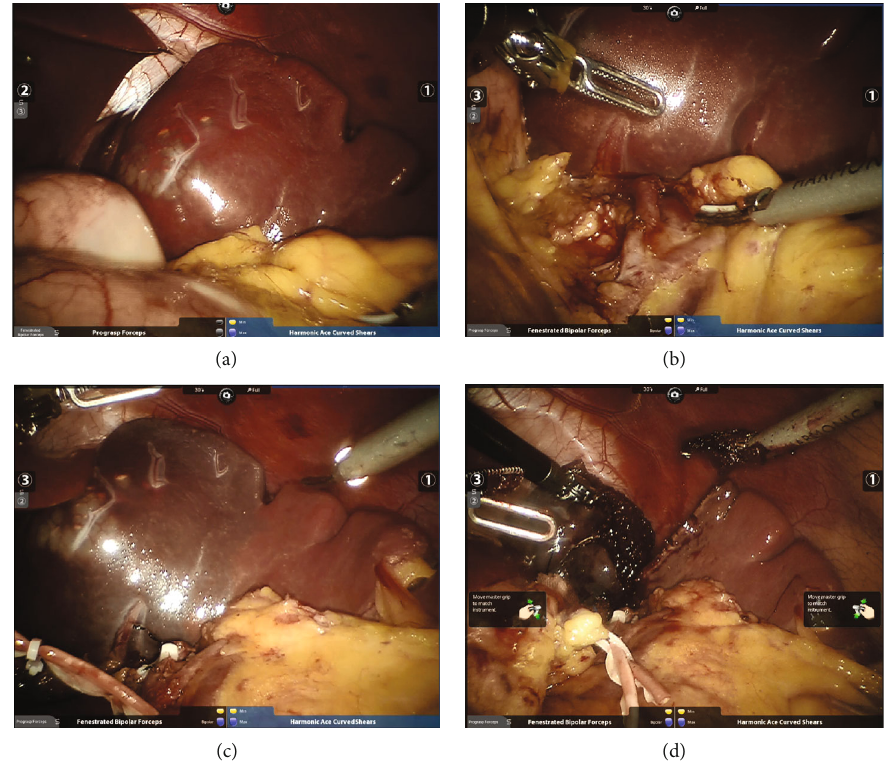
Figure 2: Intraoperative fi ndings: (a) splenic space occupied during operation; (b) free secondary vessels of the splenic pedicle; (c) after disconnection of secondary vessels of the splenic pedicle, ischemic line on the surface of the spleen can be seen; and (d) along the ischemic line, the spleen of an a ff ected side can be